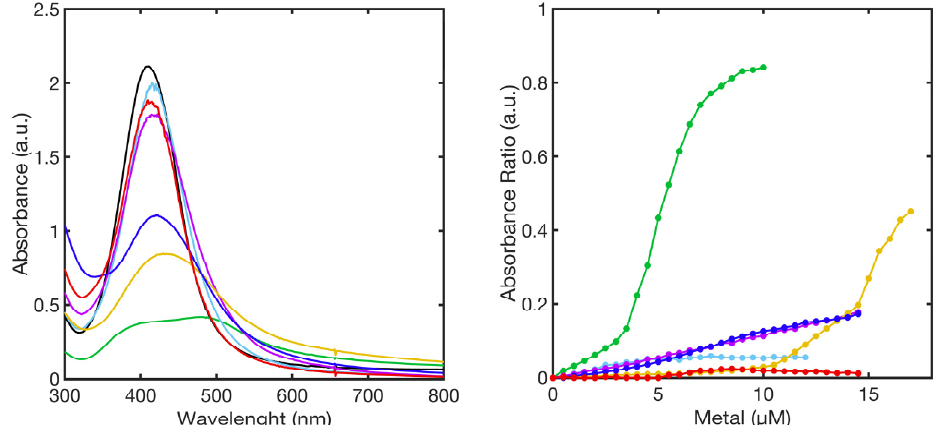
Figure 7. SPABs of FL–AgNPs@11MUA (black line) obtained at the highest concentration of metal ions ( left -panel); calibration curve showing the relationship between absorbance ratio and metal ion concentration used in the titrations ( right -panel). Ni 2+ (green line), Mn 2+ (blue line), Cu 2+ (red line), Zn 2+ (cyan line), Co 2+ (purple line), and Cd 2+ (yellow line).